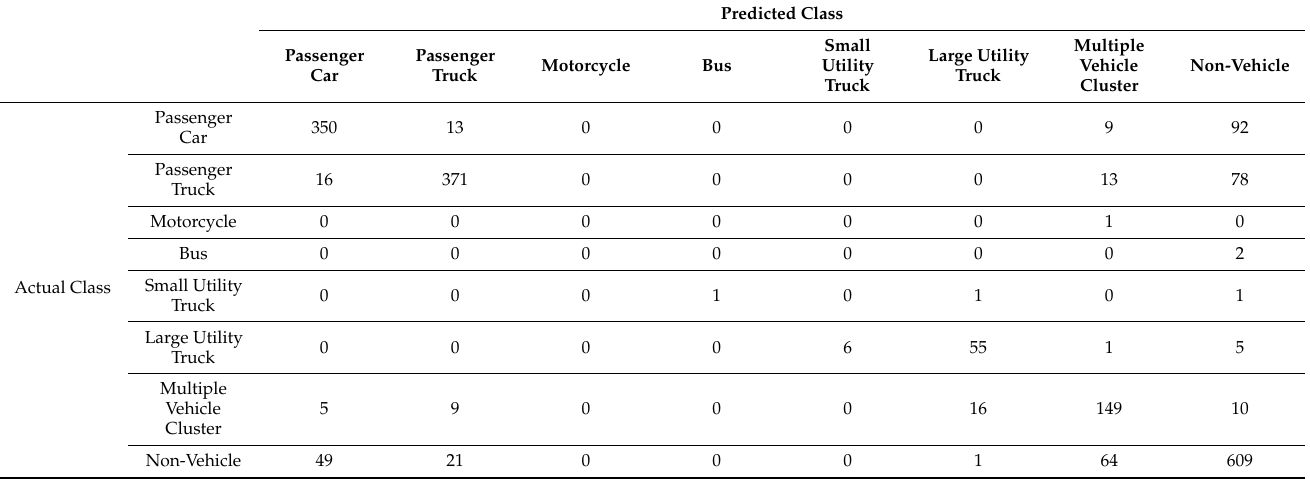
Table 14. Confusion matrix for all vehicles in Video 3.